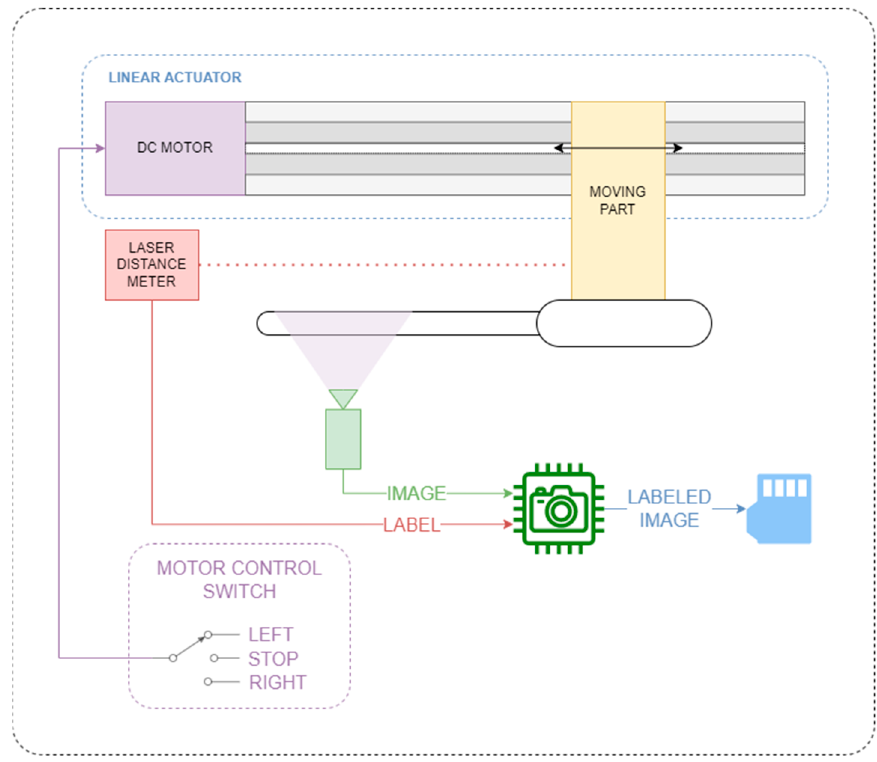
Figure 5. Dataset acquisition apparatus structural and functional illustration.